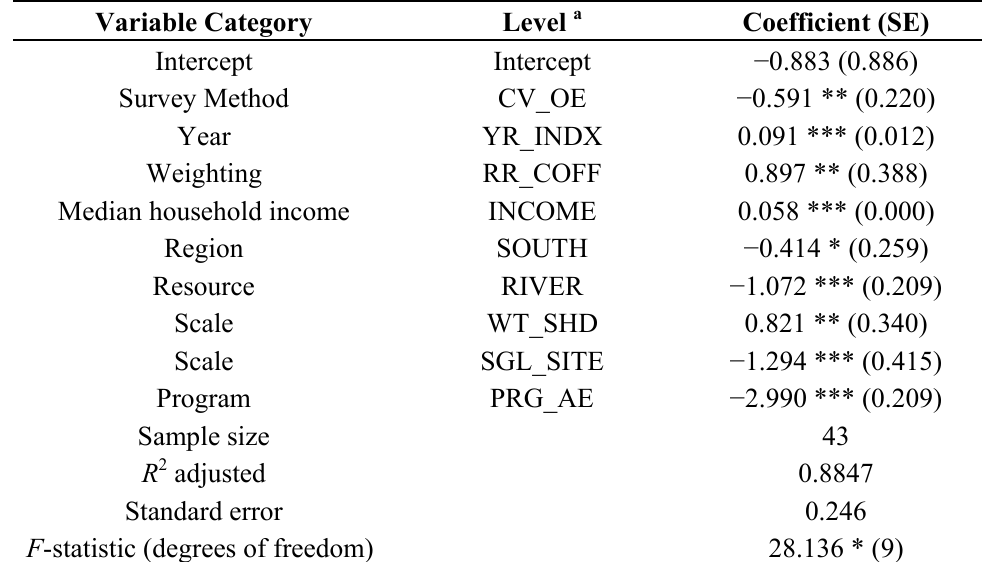
Table 3. Regression Model Results for Individual